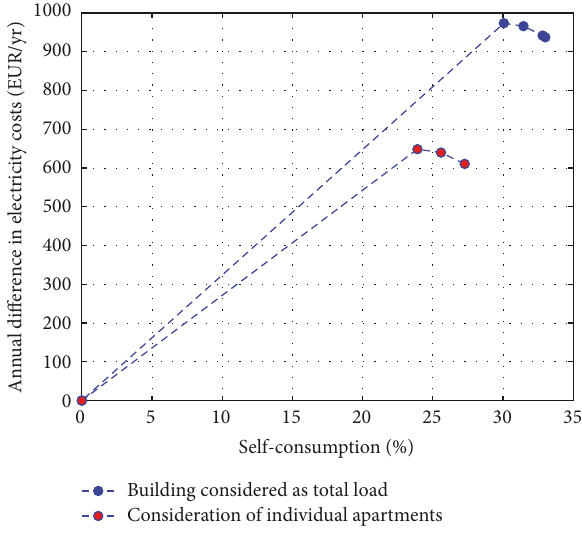
Figure 18: Austrian retail electricity prices, comparison between buildings considered as total load and consideration of individual apartments’ load profiles: annual differences in electricity costs with and without a PV system. The border between profitability and no profitability is emphasized by the blue solid line.